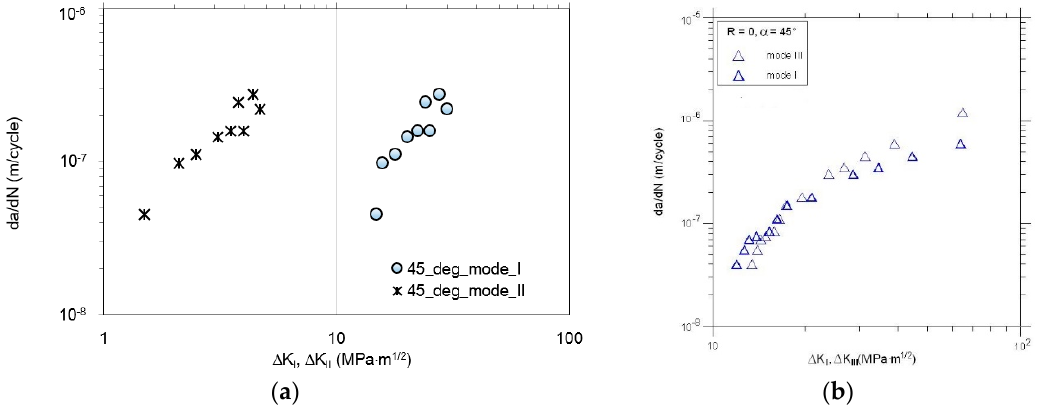
Figure 11. Comparison of the fatigue crack growth rates vs. ∆ K for α = θ = 45 ◦ : ( a ) Mode I and II; ( b ) mode I and III.